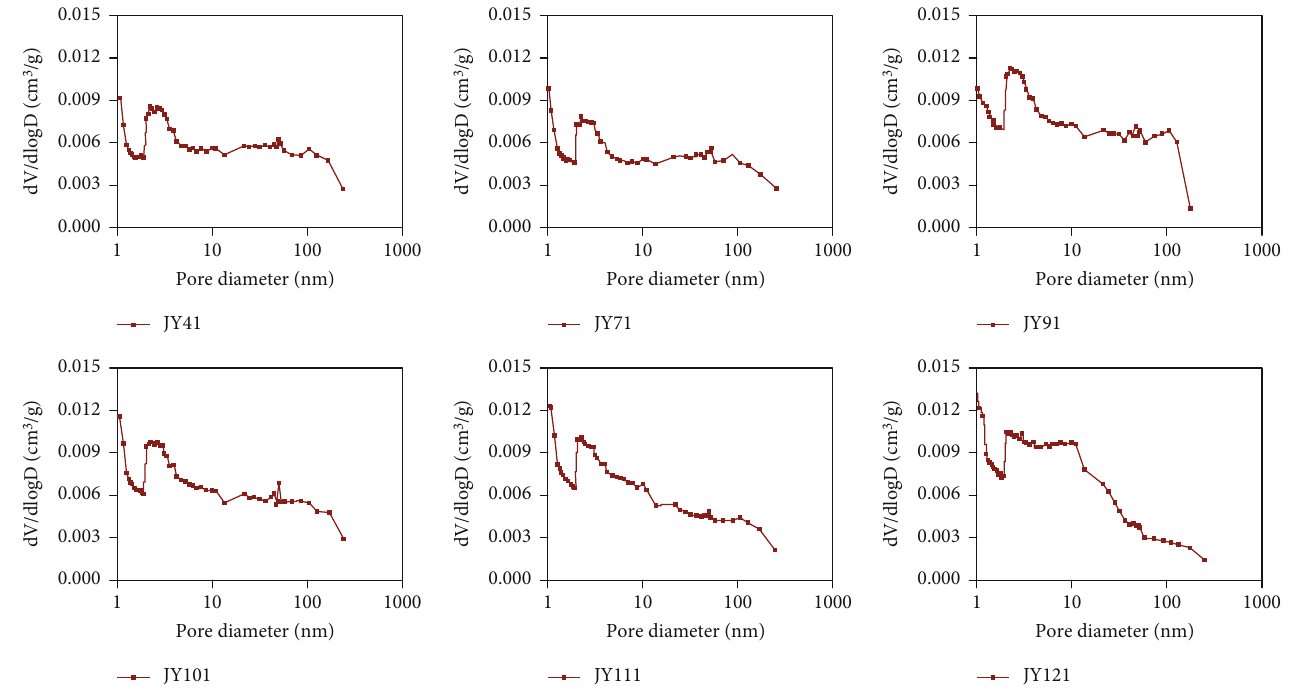
Figure 3: Pore size distribution of shales derived from low-pressure nitrogen adsorption using BJH method.